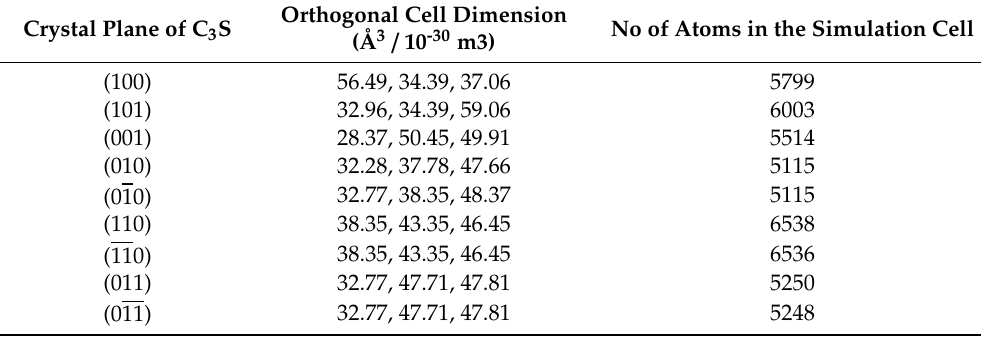
Table A1. Crystallographic data for the orthogonal simulation cells of di ff erent planes of C 3 S. Crystal Plane of C 3 S